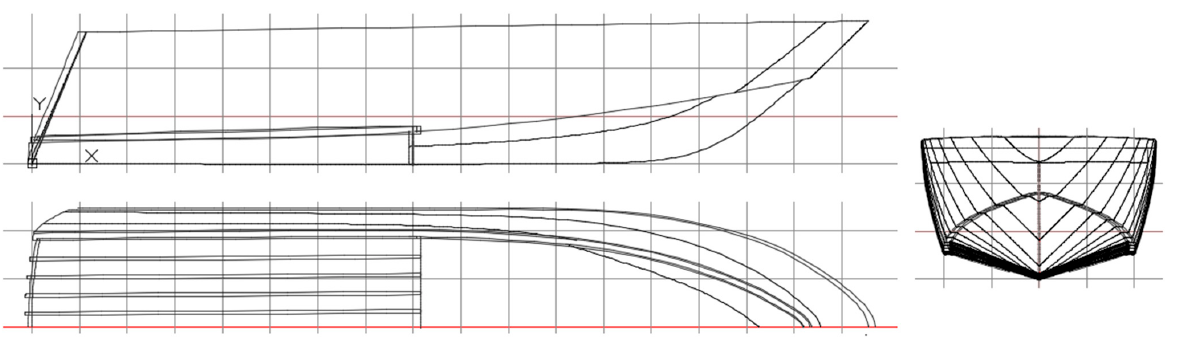
Figure 1. Multi-Step hull–Position of rails.